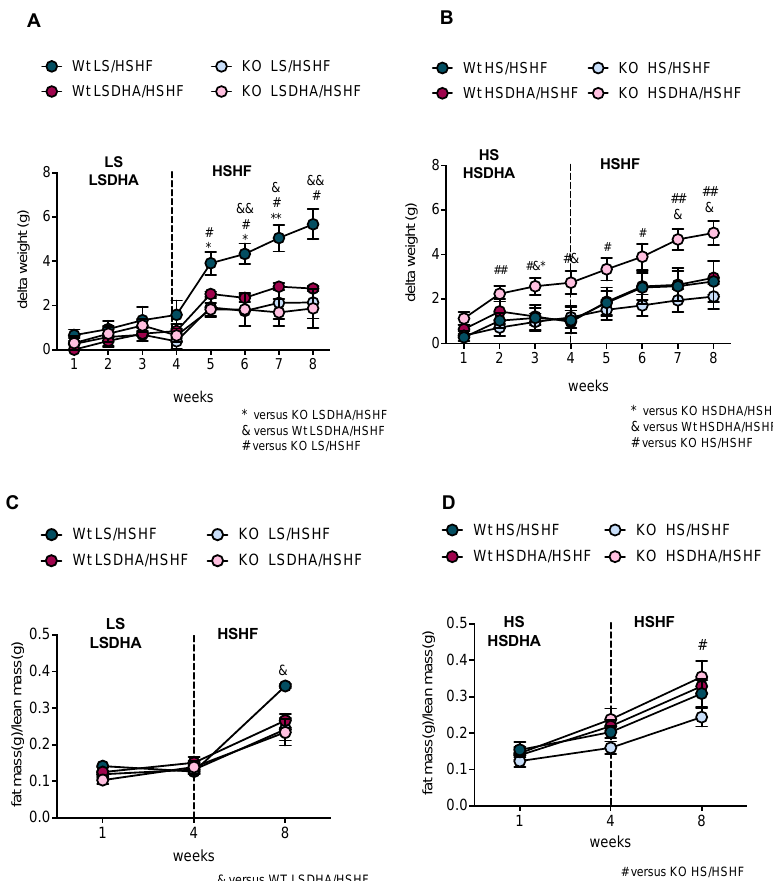
Figure 2. Sucrose content in DHA-enriched diet has an impact on gaining of weight by Elovl2 - / - mice. ( A ) Development of body weight in wild-type and Elovl2 - / - animals fed low-sucrose diet (LS) or low-sucrose DHA-enriched diet (LSDHA), followed by high-sucrose, high-fat diet (HSHF). ( B ) Body weight of animals fed high-sucrose (HS) or high-sucrose DHA-enriched diet (HSDHA) followed by high-sucrose, high fat diet (HSHF). ( C ) Obesity index for wild-type and Elovl2 - / - mice, presented as ratio of fat mass (g) to lean mass (g), at the beginning of the treatment, after four weeks of low-sucrose (LS) or low-sucrose DHA-enriched diet (LSDHA), and after additional four weeks of HSHF diet. ( D ) Obesity index at the beginning of the treatment, after four weeks of high-sucrose (HS) or high-sucrose DHA-enriched diet (HSDHA), and after four weeks of high-sucrose, high-fat diet (HSHF). Results shown are means of 4–9 mice ± SEM. Statistical significances are shown between groups * p < 0.05 and ** p < 0.01. # p < 0.05 and ## p < 0.01. & p < 0.05 and && p < 0.01.